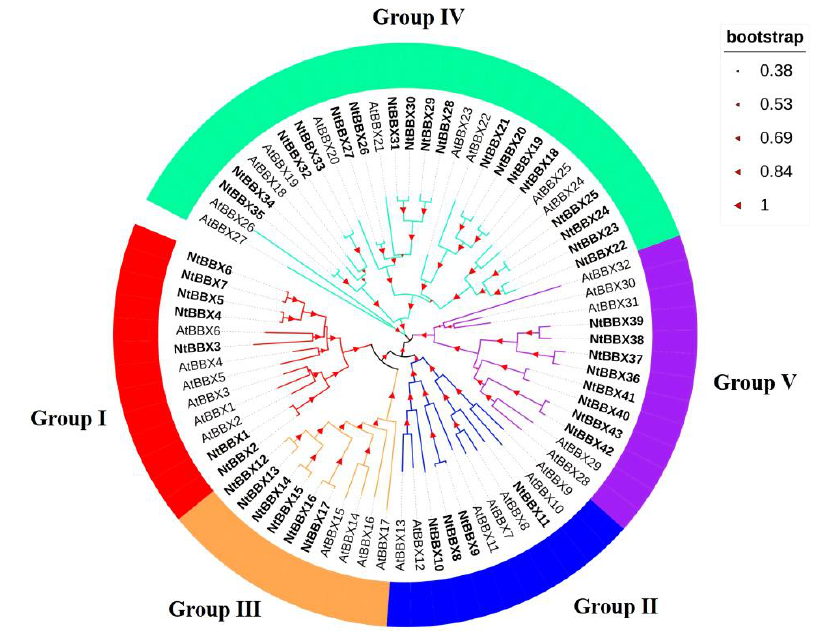
Figure 1. Phylogenetic tree of BBX proteins sequences from tobacco and Arabidopsis. The phylogenetic tree was constructed using MEGA-X with the Neighbor-Joining (NJ) method with 1000 bootstrap replications. The tree was divided into five groups, and the bootstrap values were indicated by the size of asterisks.